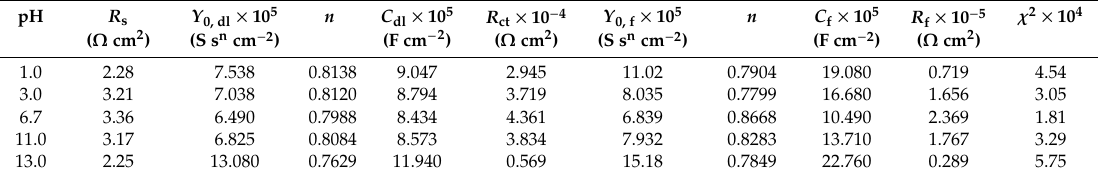
Table 4. Fitted impedance parameters for galena in NaCl solutions with di ff erent pH values.